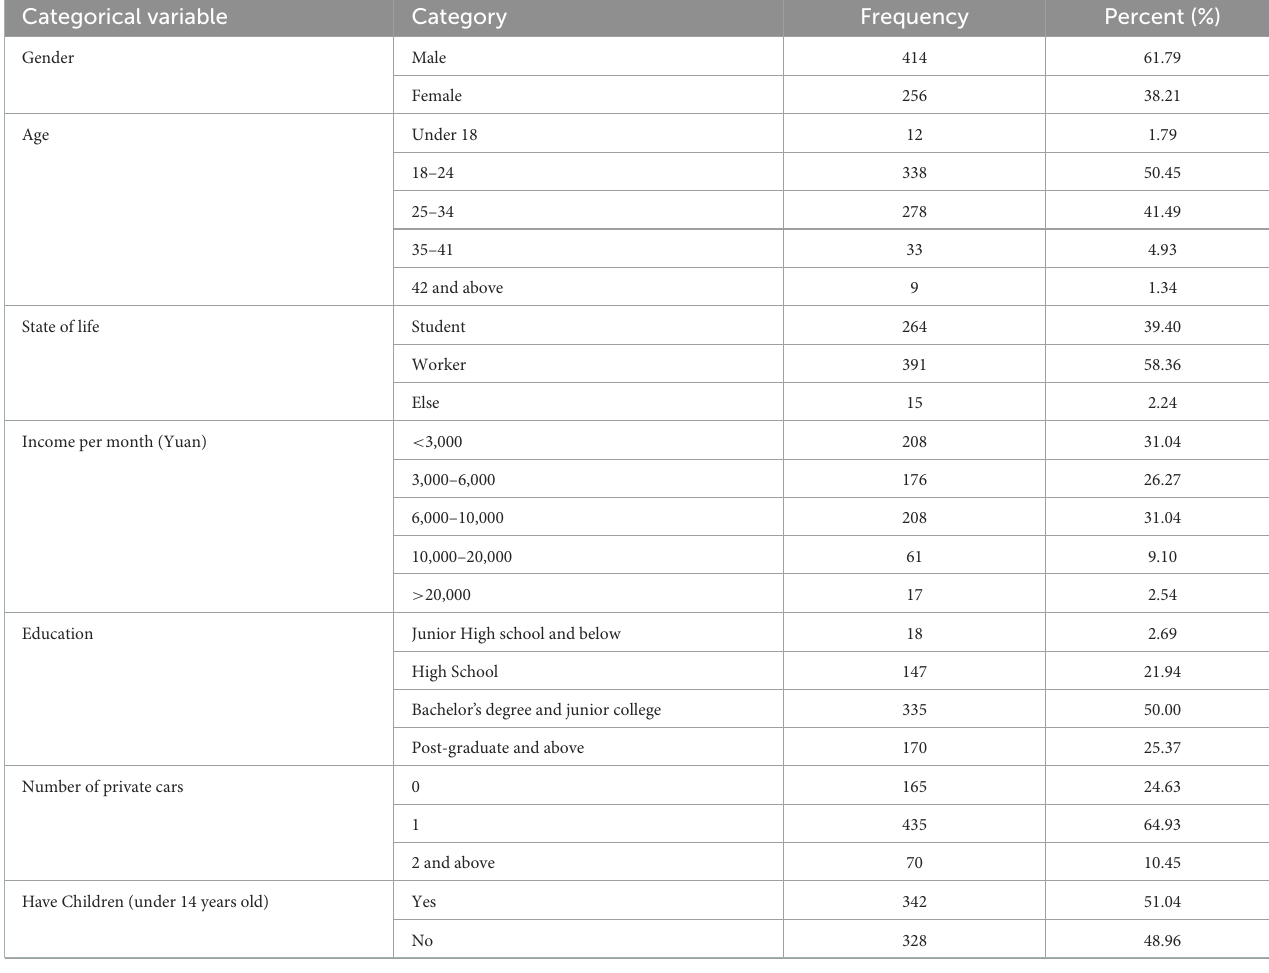
TABLE 1 Demographics and socioeconomics of the sample. Categorical